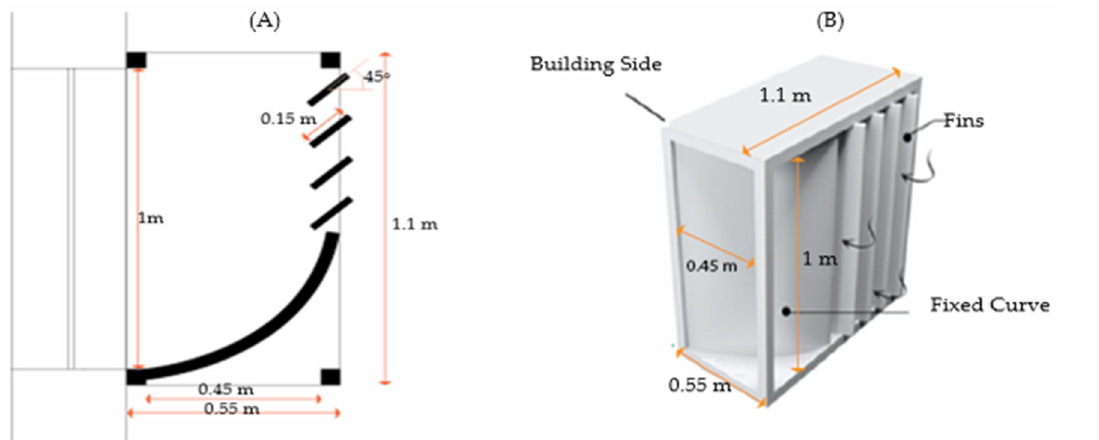
Figure 2. The design and dimensions of the proposed window-windcatcher. ( A ) 2D view ( B ) 3D View.